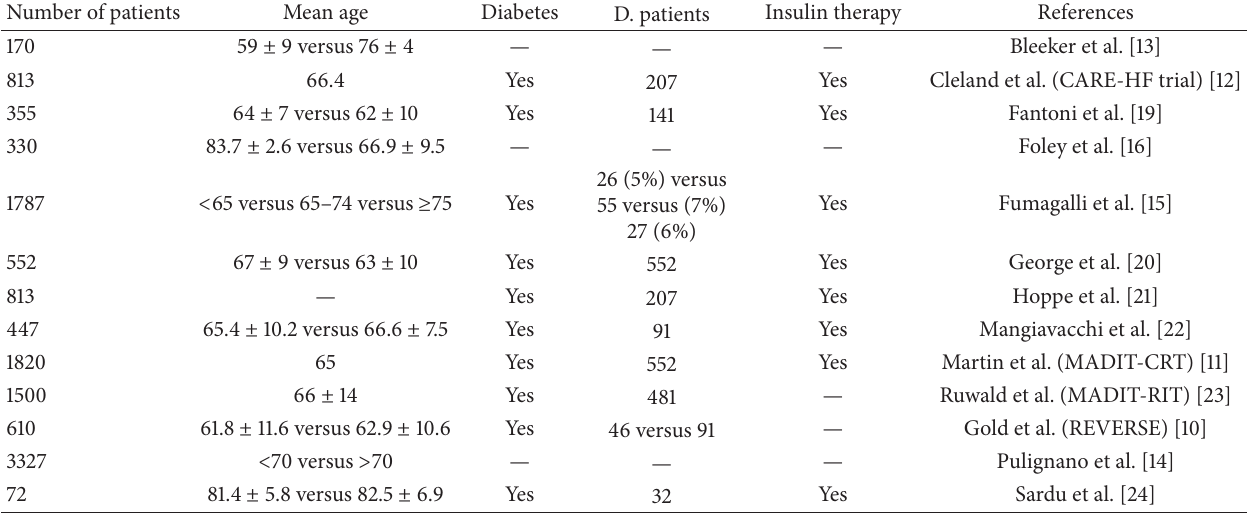
Table 1: In this table, from left to right, the following columns are reported: the number of patients, mean age of study population (in case of more than one group of patients, more mean ages are reported and compared), diabetes (diabetic diseases, yes or no), D. patients (number of diabetic patients), insulin therapy (insulin therapy, yes or no), and references, in alphabetic order with first name of authors and assigned numbers. The symbol — is used in case of information not found in the reference